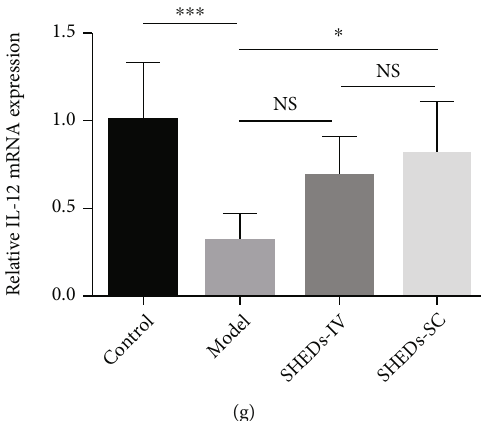
Figure 5: E ff ect of SHEDs on AD-related cytokine expression in skin tissue. (a – e) The relative mRNA levels of Th2- and Th17-mediated cytokines including IL-4, IL-5, IL-13, IL-17A, and IL-23. (f and g) The relative mRNA levels of Th1-mediated cytokines including IFN- γ and IL-12. All the data are expressed as mean ± SD ( n = 6 ). Three repeated times of each experiment were